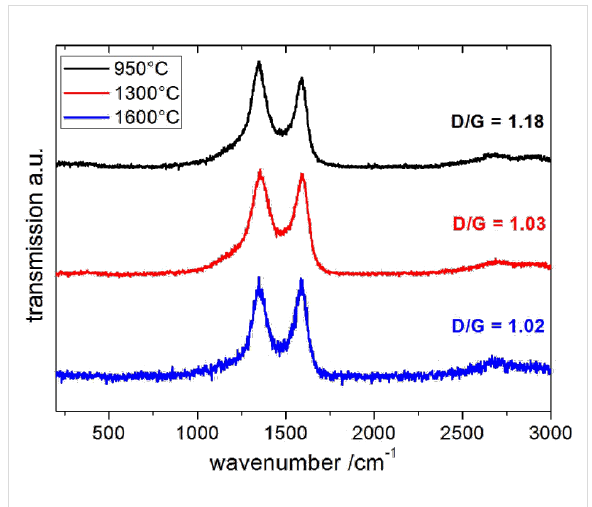
Figure 4: Raman spectra of the carbon tubes ( 4 ) carbonized at 950 °C (black/top), 1300 °C (red/middle) and 1600 °C